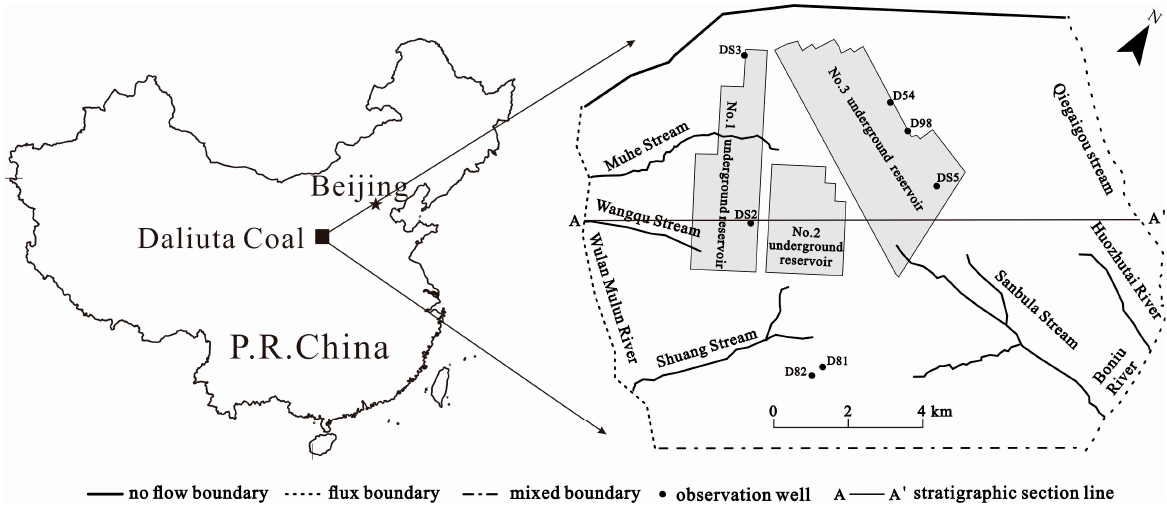
Figure 1. Schematic diagram of model